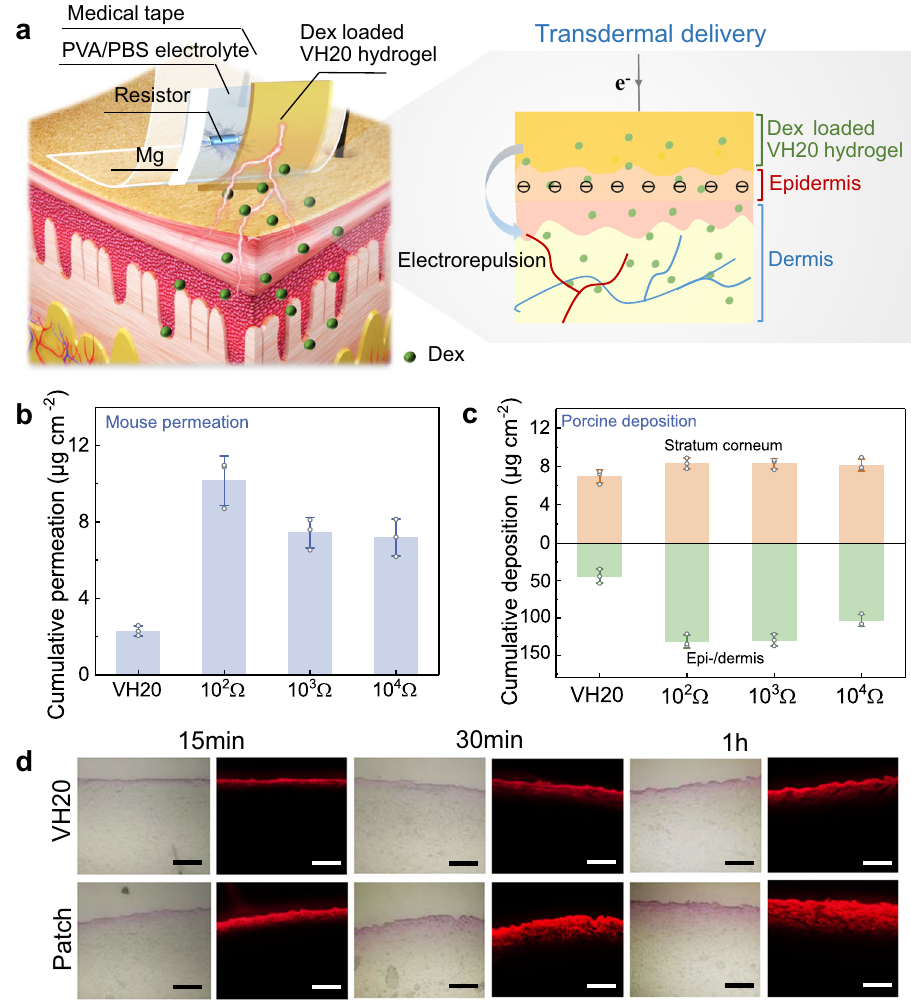
Fig. 5 | Transdermal delivery of Dex from the Mg battery-powered iontophor- esispatch.a Schemeofawearableiontophoresispatchwithbuilt-inMgbatteryfor transdermal delivery. b Cumulative permeation across the hairless mouse skin collected from the receptor chamber using a Franz diffusion cell after 3h appli- cation. ( n = 3 independent experiments). c Deposited amount within the stratum